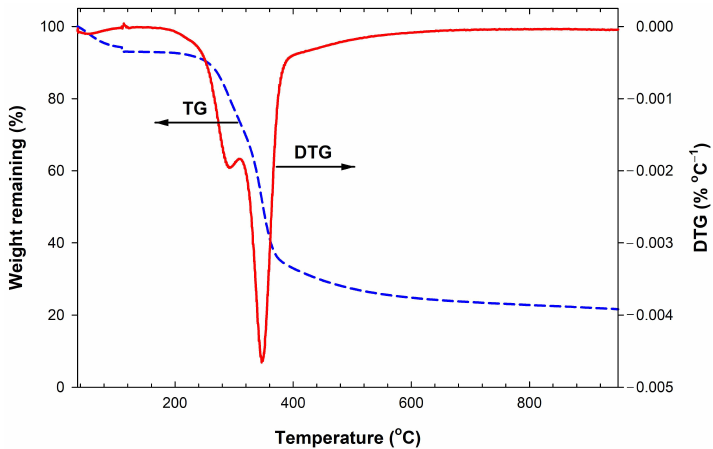
Figure 1. TG and DTG curves of bamboo biomass used in this